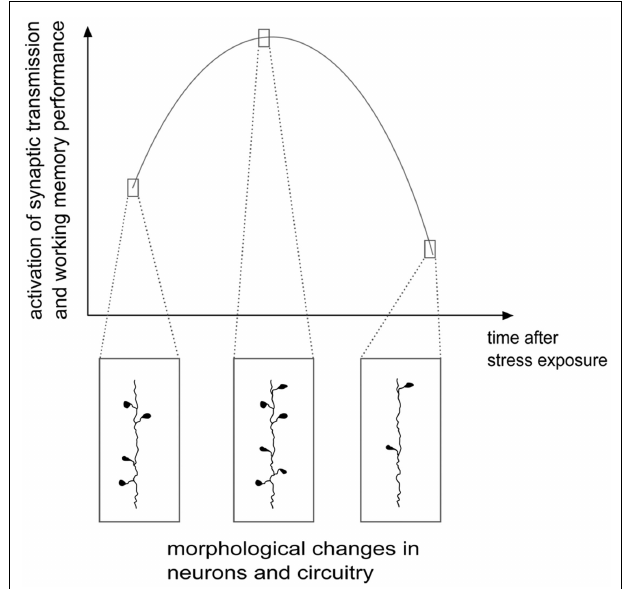
FIGURE 2 | Hypothetical scheme of structural/functional changes induced by stress in the glutamate system: a biphasic process . Stress and corticosterone were shown to induce enhancement of excitatory synaptic transmission and increase in the number of spines and synapses, often accompanied by cognitive enhancement, in the first several minutes and hours. Later on, at least 24h after application of the stressor, a phase of inhibition follows, with reduction of synaptic transmission, dendritic atrophy and remodeling, loss of spines and synapses and negative effects on cognitive functions. See text for details. Adapted from Musazzi et al.